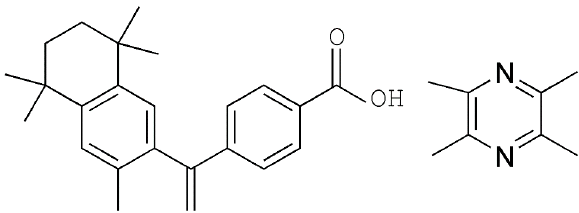
Figure 1. Chemical structure of bexarotene (BEX) ( left ) and ligustrazine (LIG) ( right ).